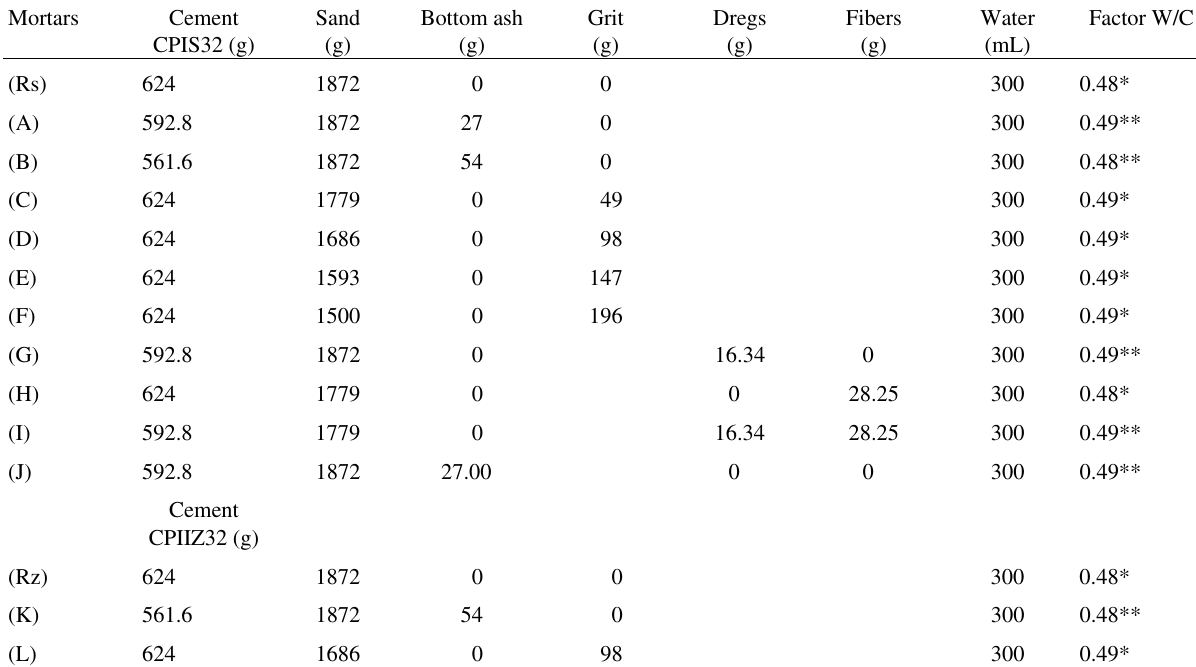
Table 3. Amount of materials used to produce the mortars. * Water/cement factor. ** Water/(cement plus bottom ash/dregs) factor. Mortars